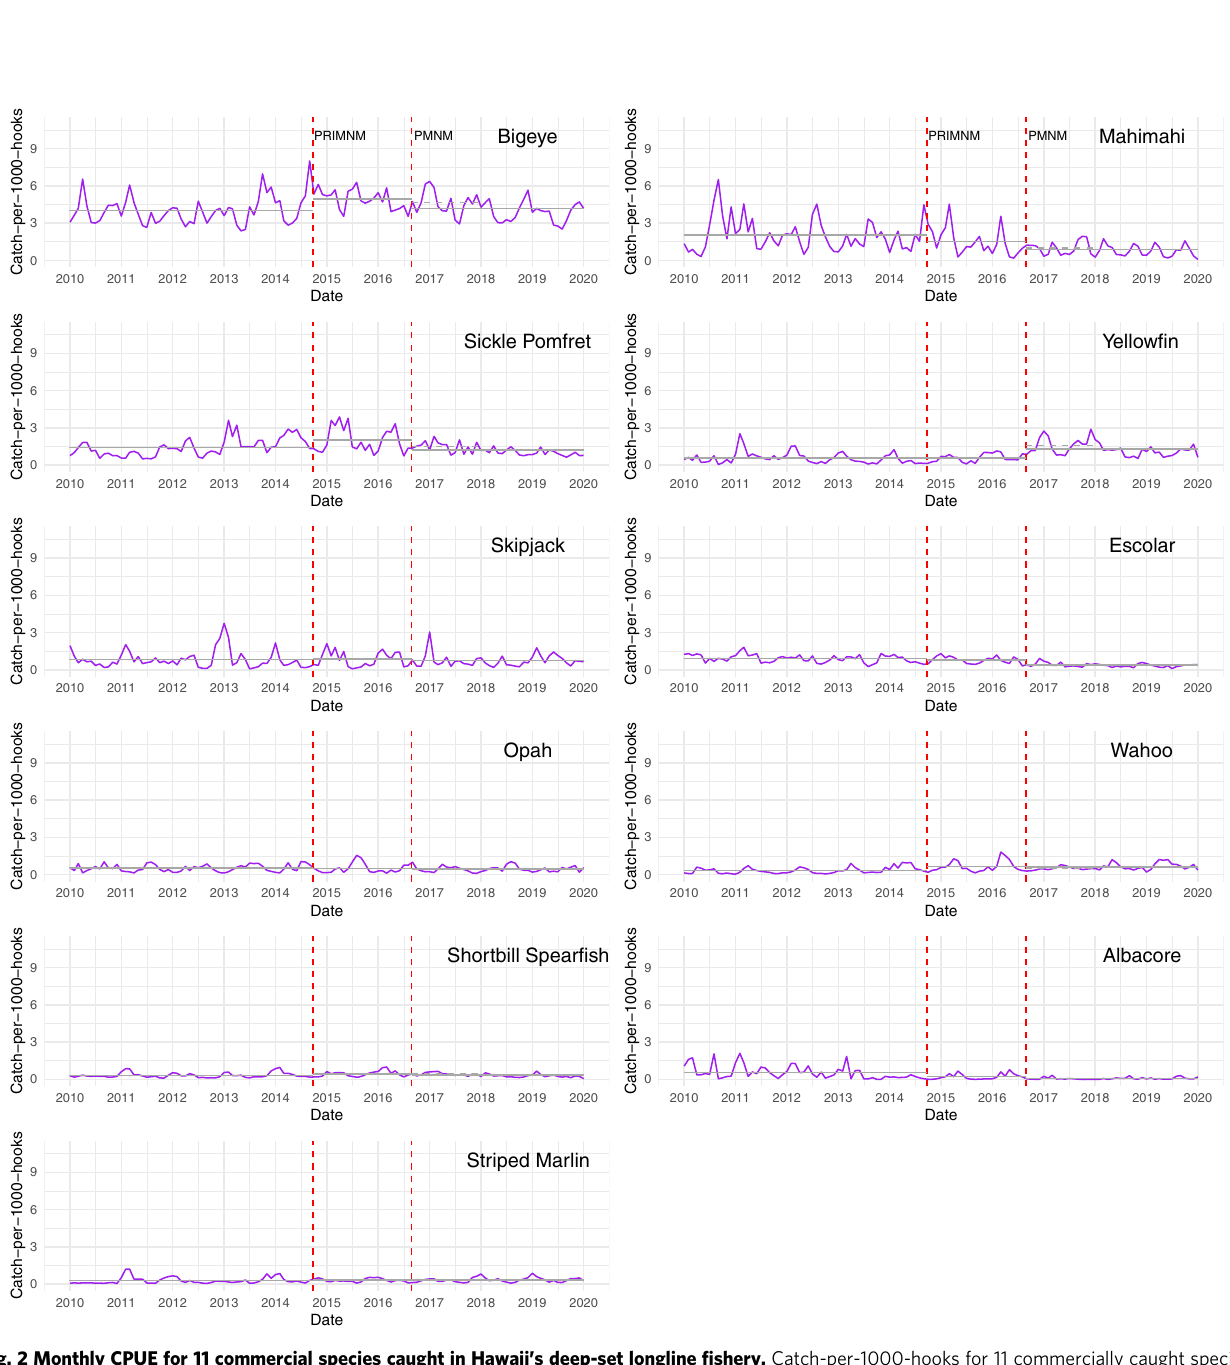
Fig. 1 Monthly CPUE and RPUE calculated using two measures of catch composition. a Catch-per-1000-hooks measured by aggregate commercial catch (blue) and Bigeye + Yellow fi n tuna catch (gold) calculated using data from the NOAA Observer Program. Solid horizontal lines indicate average catch rates over the designated time periods. Dashed lines indicate average catch rates in the post-PMNM expansion period presented in Lynham et al. 1 . The two red dashed lines indicate the Paci fi c Remote Island Marine National Monument expansion (PRIMNM) and the Papah ā naumoku ā kea Marine National Monument expansion (PMNM). b Revenue-per-1000-hooks aggregated for 11 commercially caught species (blue) and Bigeye + Yellow fi n (gold). Revenue-per-1000-hooks was approximated by multiplying the number of individuals caught by the average value of individual fi sh for each species, then dividing by effort measured in 1000 s of hooks. The average value of individual fi sh was calculated using observed fi sh sales from 2010 to 2019 from Hawaii ’ s dealer data. The two red dashed lines indicate the Paci fi c Remote Island Marine National Monument expansion (PRIMNM) and the Papah ā naumoku ā kea Marine National Monument expansion (PMNM).